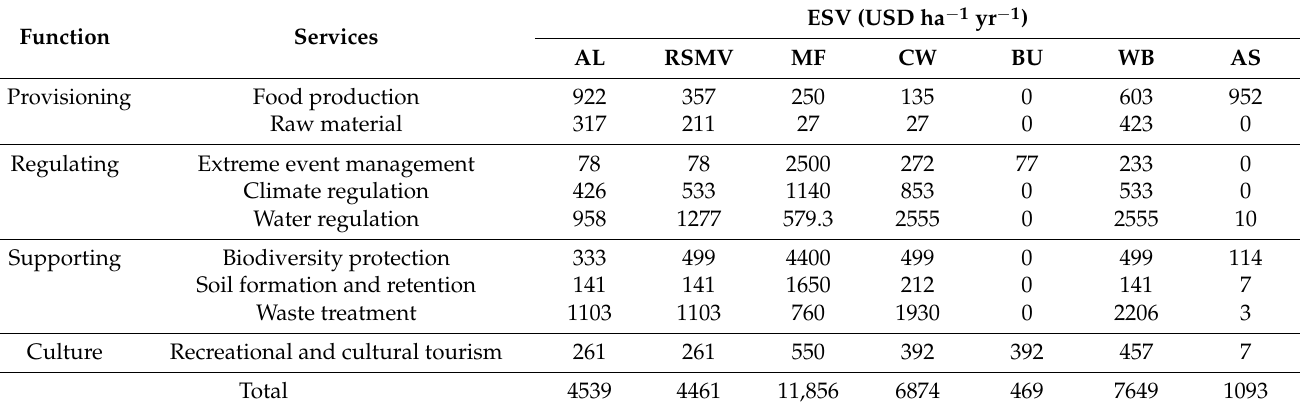
Table 3. Monetary valuation (USD ha − 1 yr − 1 ) of ecosystem services of different LULC types in coastal